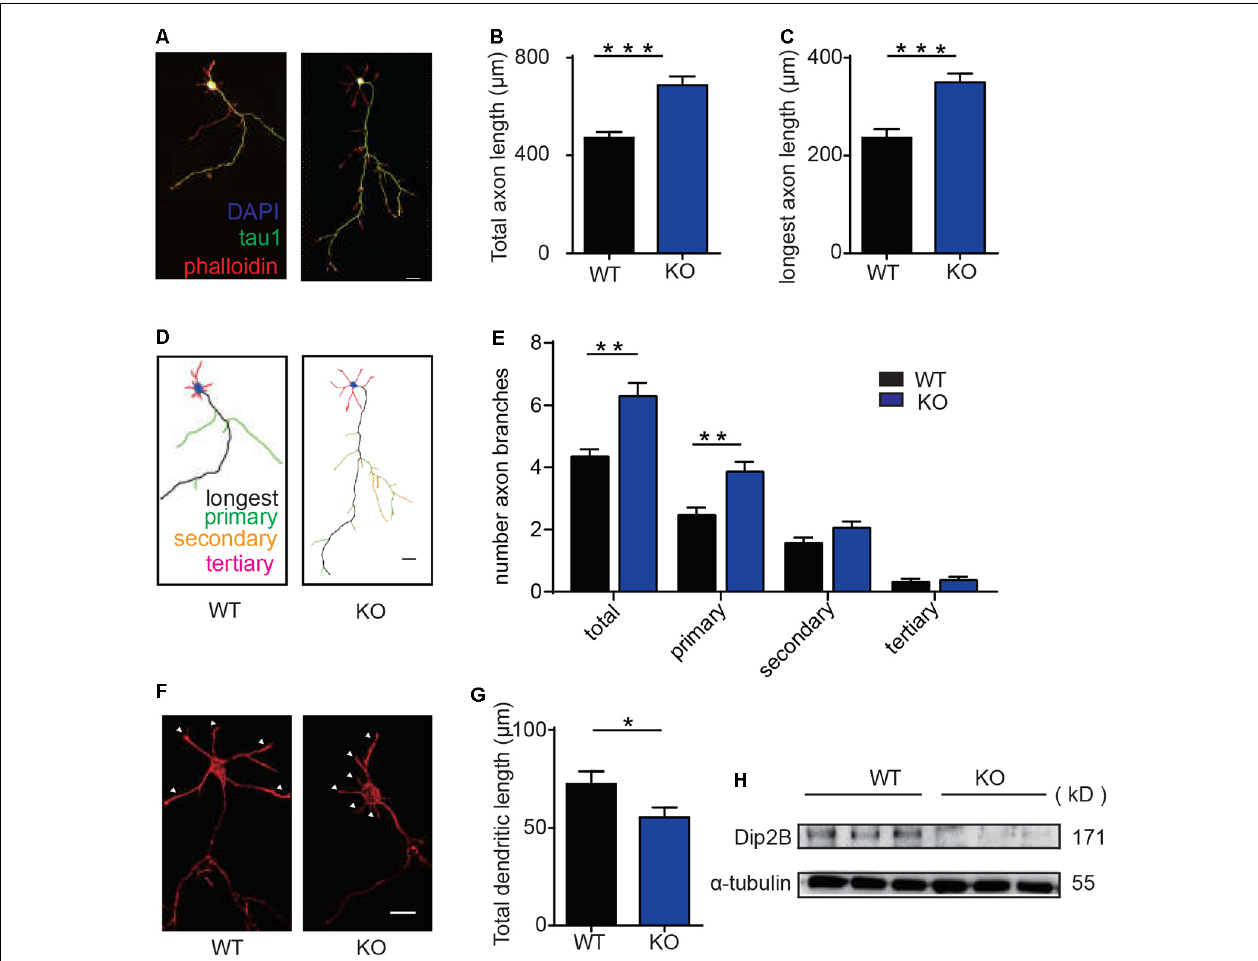
FIGURE 2 | DIP2B is required for axon development in cultured hippocampal neurons. (A) Representative imagines of axonal development at DIV4 from cultured hippocampal neurons. wild type (WT): littermate controls of DIP2B KO mice; KO: DIP2B knockout mice. Green: tau-1; Red: phalloidin; Blue: DAPI. Scale bar: 20 µ m (WT, n = 40; KO, n = 51). (B) Average total axonal length from panel (A) . (C) The average length of the longest axon from panel (A) . (D) Schematic depiction of axonal development at DIV4 from cultured hippocampal neurons. Scale bar: 20 µ m. (E) Average axonal branching from panel (A) . (F) Representative imagines of dendritic outgrowth at DIV4 from cultured hippocampal neurons. WT: littermate controls of DIP2B KO mice; KO: DIP2B knockout mice. Red; phalloidin. Scale bar: 20 µ m. (G) Average dendritic length. (H) DIP2B expression in the brains of control and DIP2B KO mice. An unpaired t- test was used for comparisons. * p < 0.05; ** p < 0.01; *** p < 0.001; n, cell number. Error bars represent SEM. For further details, see Supplementary Table S1